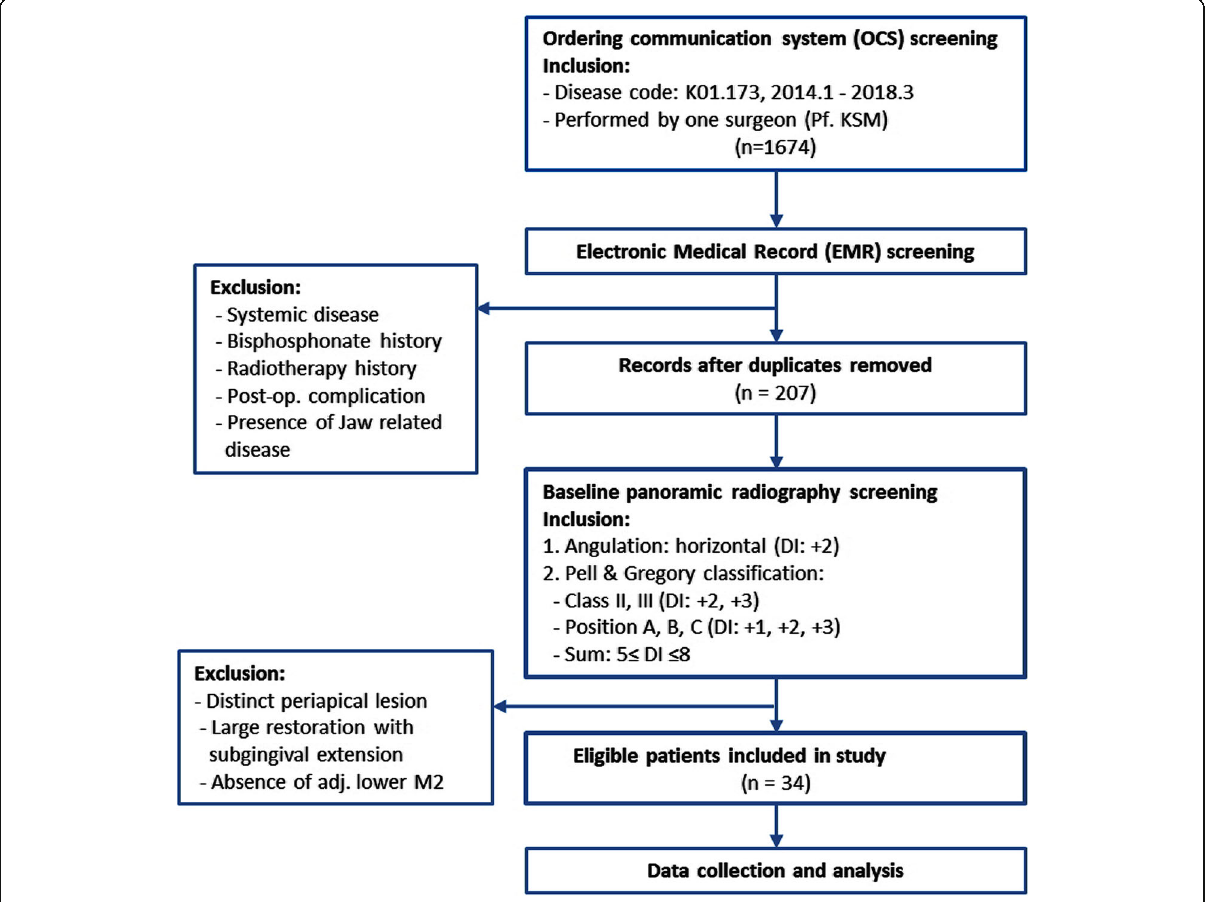
Fig. 1 Screening sequence using OCS, EMR, and panoramic